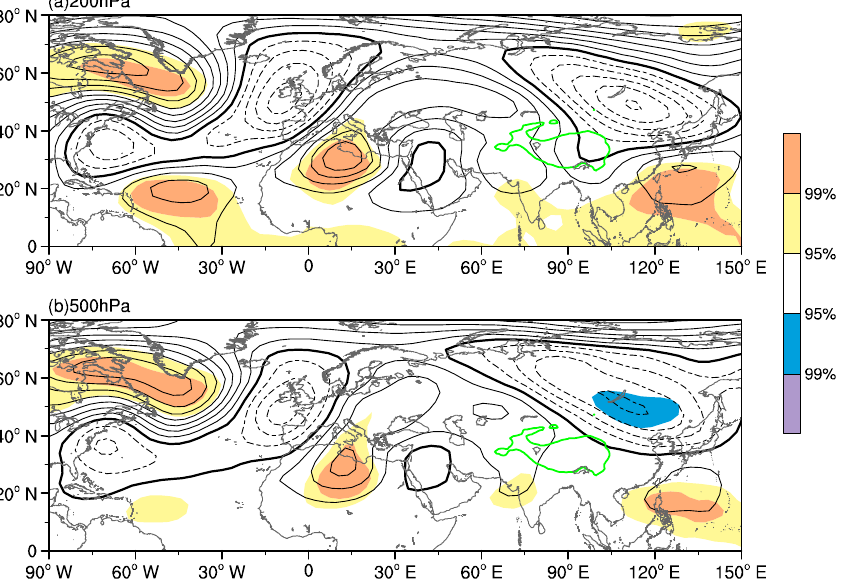
Figure 8. ( a ) April 200-hPa geopotential height anomalies (units: gpm) obtained by regression on the simultaneous high-latitude North Atlantic SST index for the period 1981–2019. ( b ) As in ( a ) but for the 500-hPa level. Contours are drawn every 4 gpm. The bold black line is zero. The solid and dash lines denote positive and negative values, respectively. Shadings denote geopotential height anomalies significant at the 95% and 99% confidence levels as shown by the color bars.